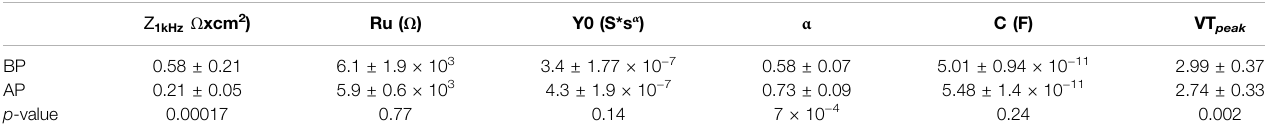
TABLE 2 | Mean and standard deviation of the normalized impedance at 1 kHz, list of all components extracted from the equivalent circuit model reported as inset in Figure 5A , VT peak before and after pulsing. The p -values from the paired t-test are reported with a signi fi cance difference for the α value of the CPE and for both normalized impedance and VT peak